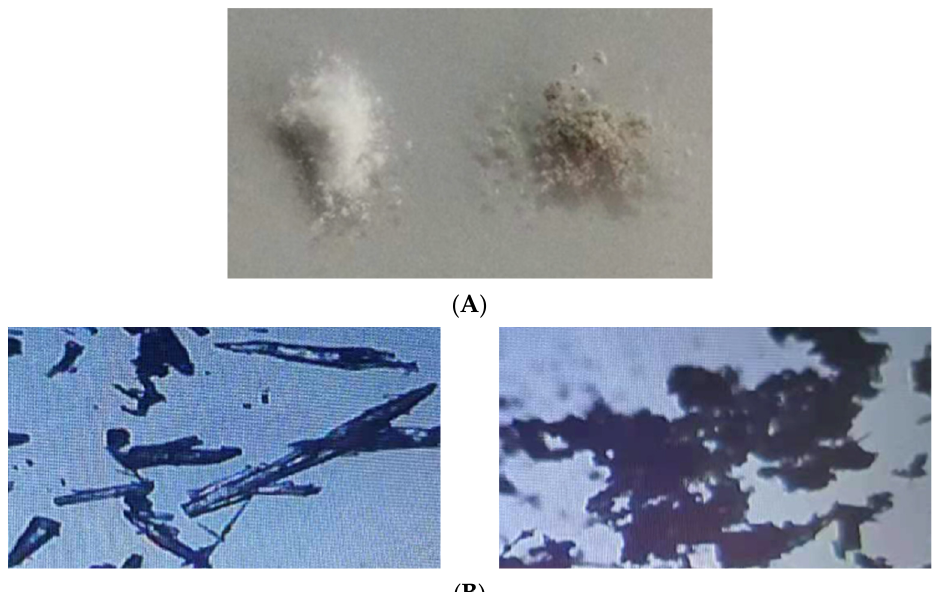
Figure 4. Characterization of MOF Zn(BTC) 4 and EGCG@MOF Zn(BTC) 4 . ( A ) Gross images of MOF Zn(BTC) 4 and EGCG@MOF Zn(BTC) 4 ; ( B ) Microscope images of MOF Zn(BTC) 4 and EGCG@MOF Zn(BTC) 4 (40×).